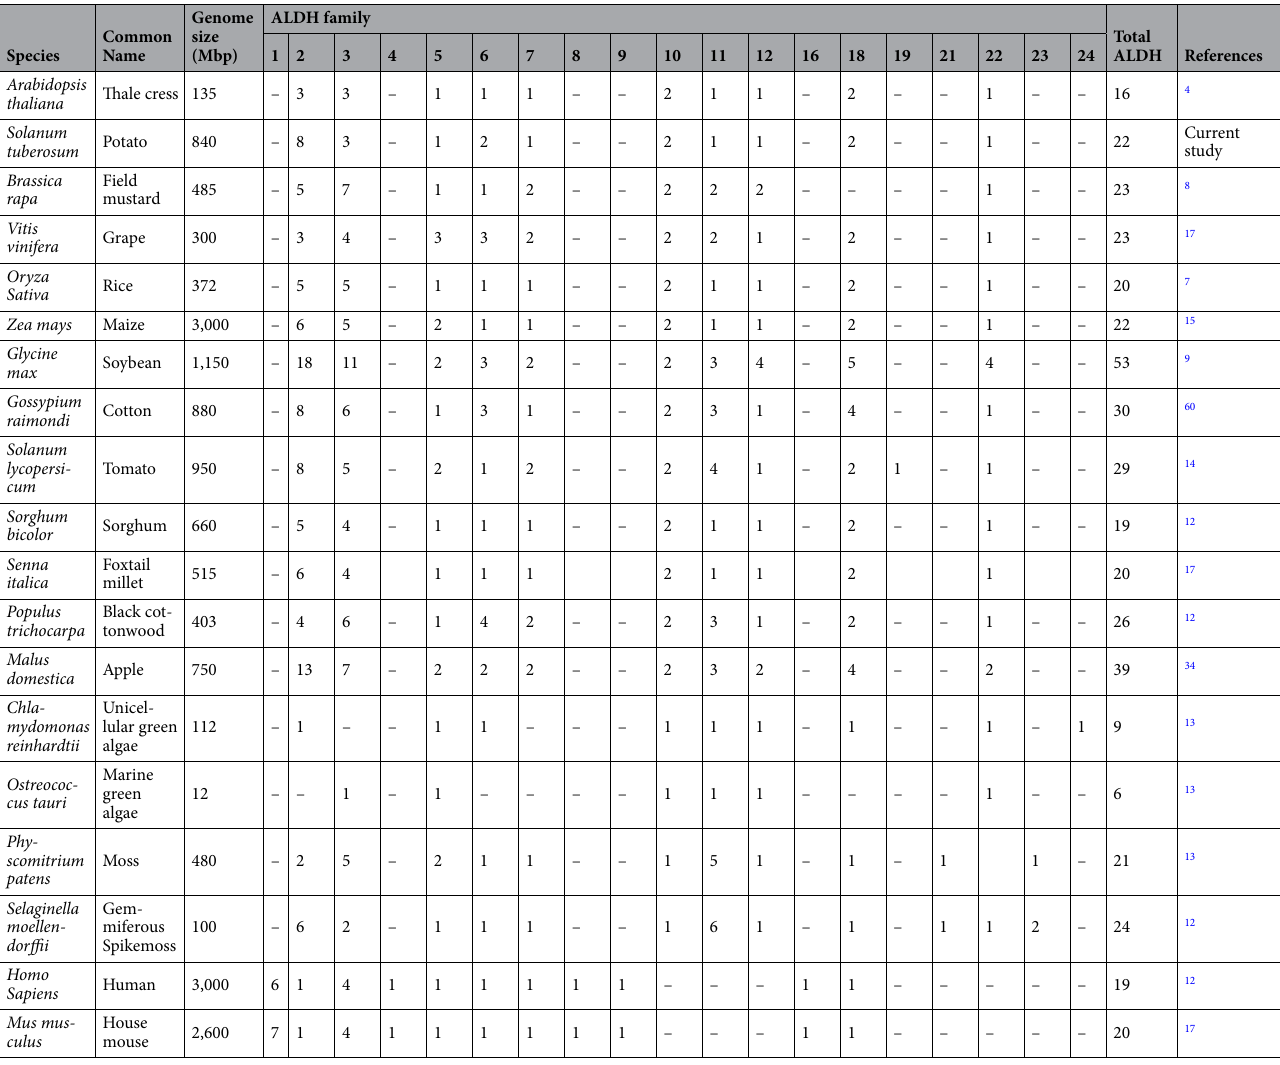
Table 1. Comparative identification of the ALDH gene families in various